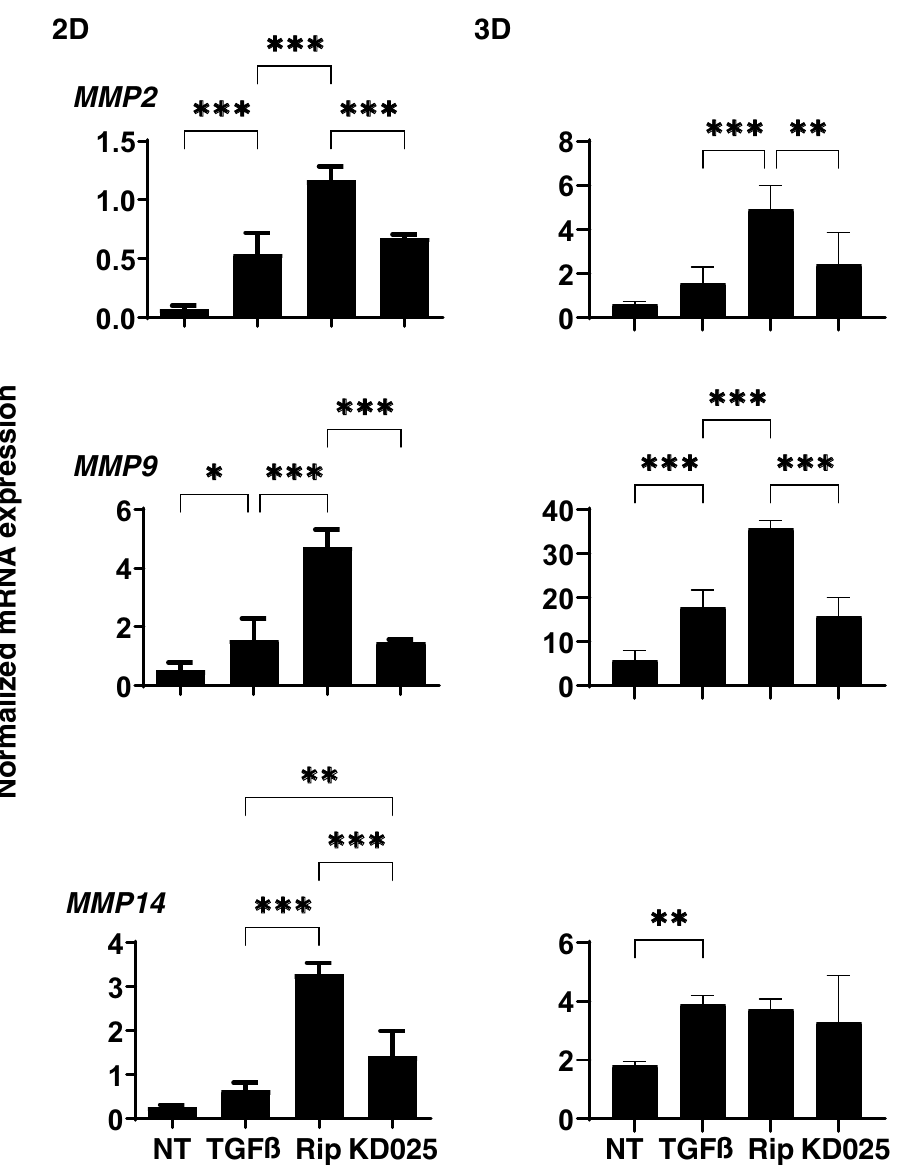
Figure 7. mRNA expression of MMPs in 2D and 3D cultured HTM cells. At Day 6, HTM 2D cells and 3D sphenoids (control) and those treated by 5 ng/ml TGFβ2 in the absence or presence of 10 μM ripasudil (Rip) or KD025 were subjected to qPCR analysis to estimate the expression of mRNA in MMP 2, 9 and 14 . All experiments were performed in duplicate each using 15–20 freshly prepared 3D HTM sphenoids for each experimental condition. Data are presented as the arithmetic mean ± standard error of the mean (SEM). * P < 0.05, ** P < 0.01, *** P < 0.005 (ANOVA followed by a Tukey’s multiple comparison